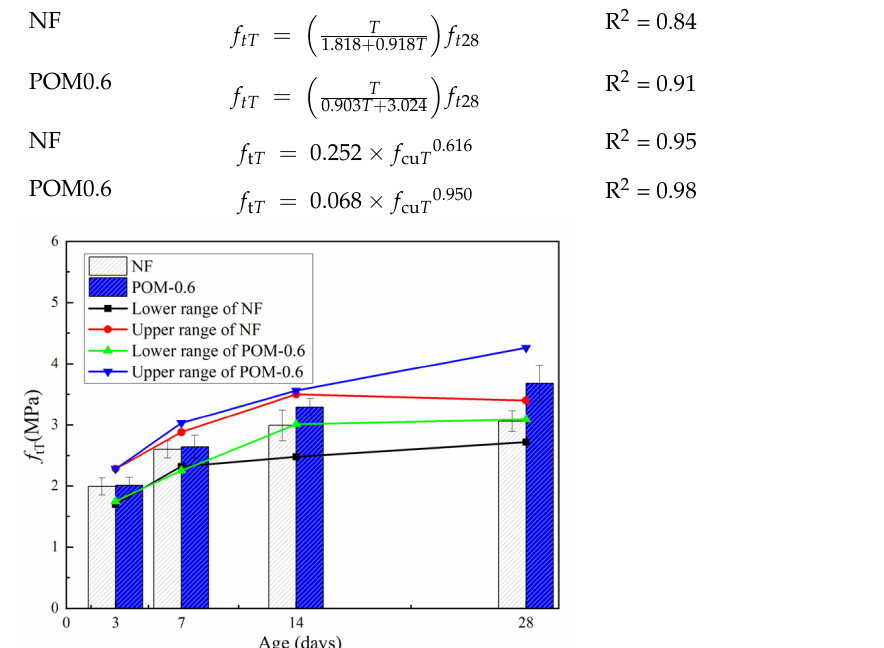
Figure 14. Test results of f tT for NF and POM0.6 SWSSC specimens with different concrete